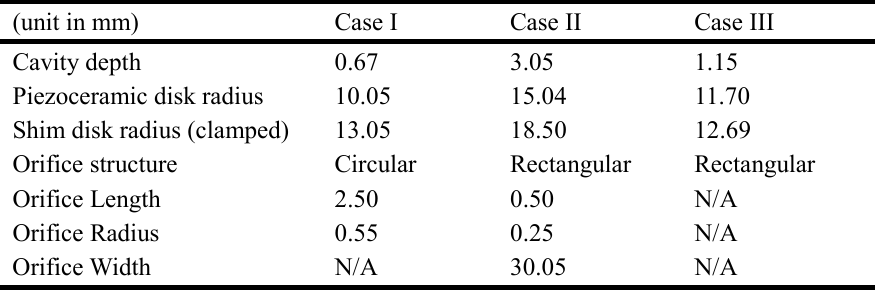
Table 2. Actuator cases dimensions* (unit in mm) Case I Case II Case III Cavity depth Piezoceramic disk radius Circular Rectangular Rectangular